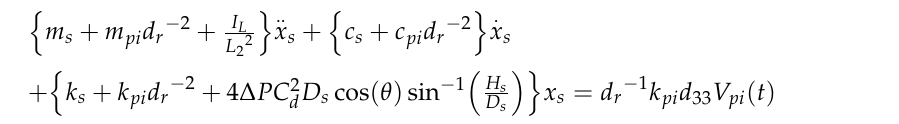
Figure 3. Hydraulic model of the spool valve.